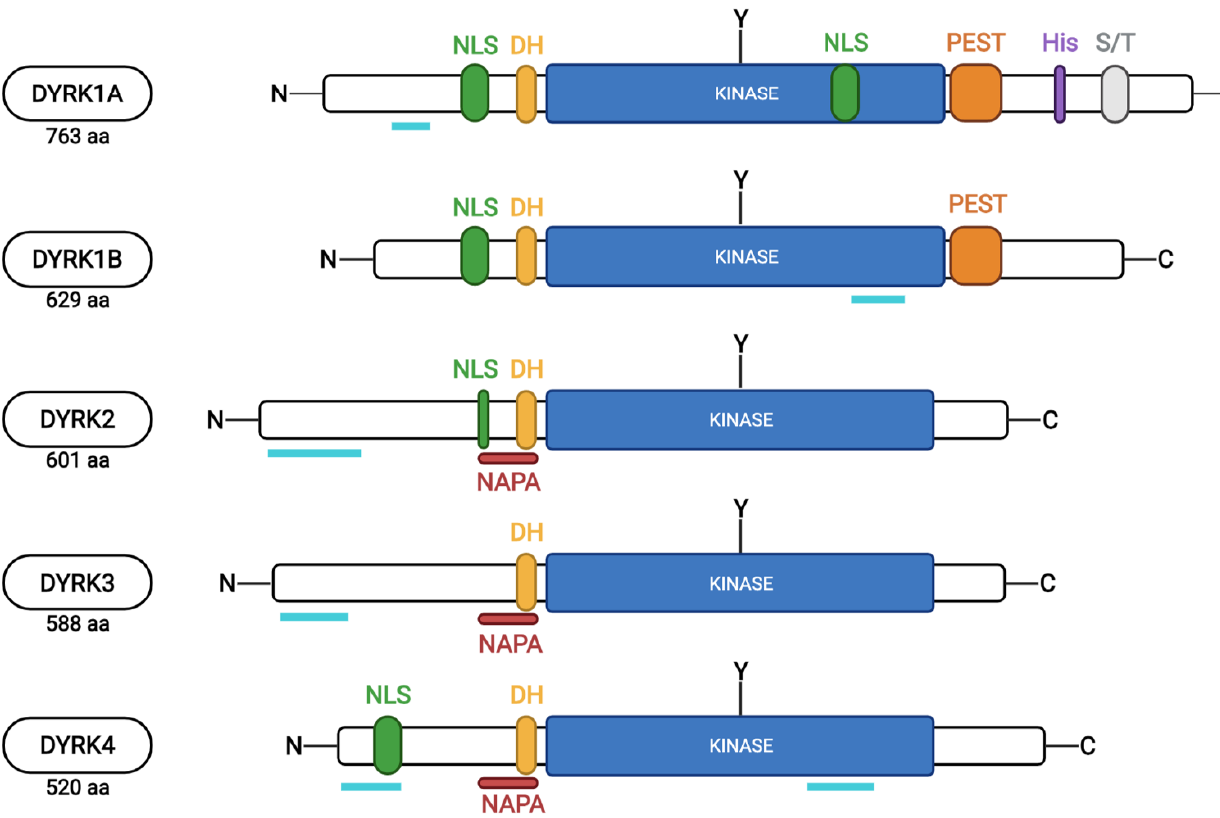
Figure 2. Schematic representation of the protein sequences of the 5 human DYRKs (from uniport.org and based on [10,24]). The different protein motifs identified are indicated: NLS, nuclear localization signal; DH, DYRK-homology box; NAPA, N-terminal autophosphorylation accessory region; kinase, kinase domain; PEST, motif rich in proline, glutamic acid, serine, and threonine residues; His, polyhistidine domain; S/T, serine and threonine-enriched domain; and Y, tyrosine residue autophosphorylated by DYRKs within the activation loop. Turquoise lines indicate protein regions affected by alternative splicing events.